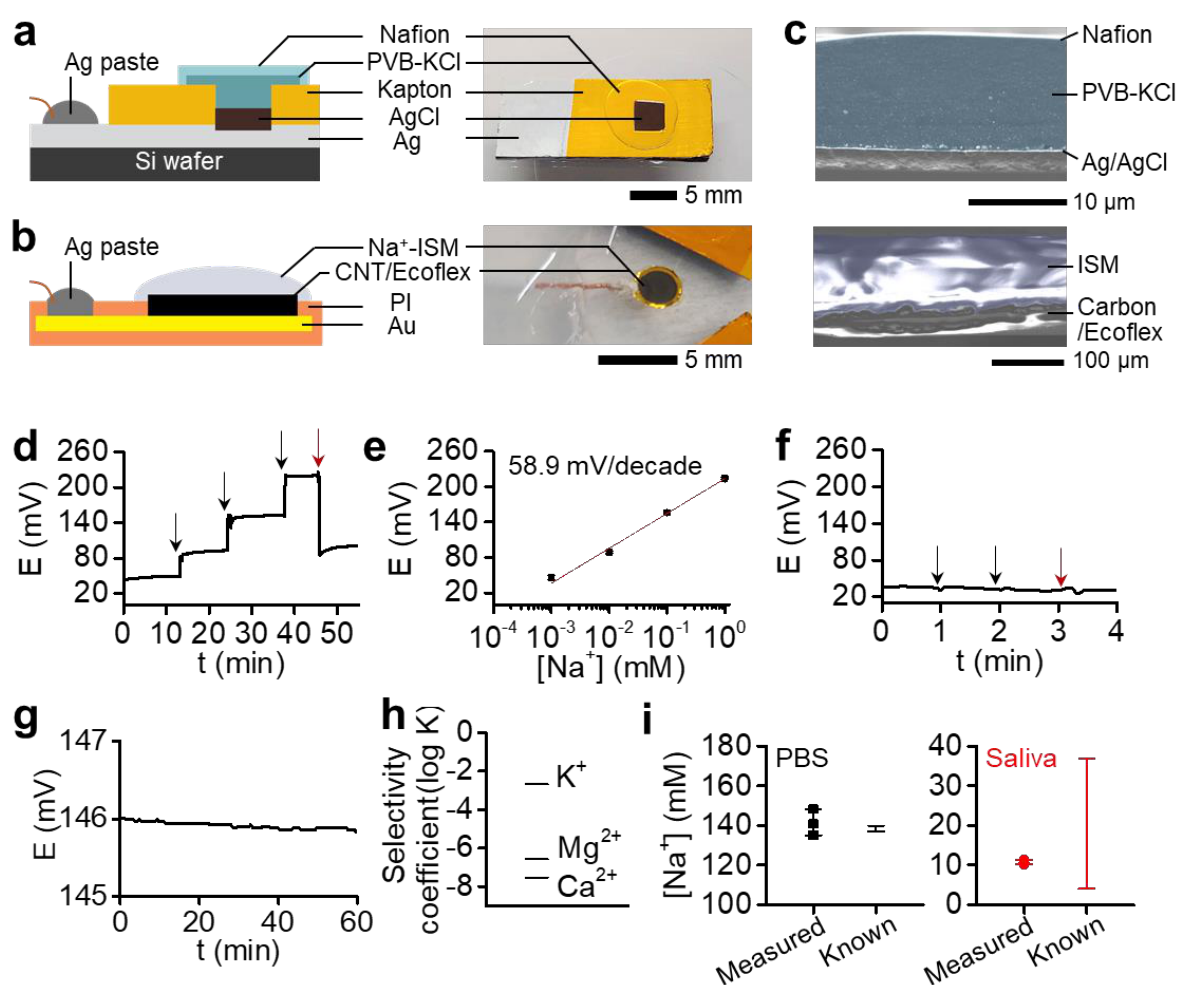
Figure 2. Characterization of a low-profile reference electrode (RE) and ion-selective electrode (ISE). ( a , b ) Schematic illustrations and photos of multilayered structures of ( a ) an Ag/AgCl/PVB-KCl/Nafion RE and ( b ) a carbon/Ecoflex-based ISE. ( c ) Cross-sectional SEM images of the RE (left) and ISE (right) in ( a , b ), respectively. ( d ) Voltage transient measured from an ISE in 10 − 3 –1 M sodium chloride solutions (black arrows) and saliva (red). ( e ) Linear correlation between measured voltages and sodium levels, showing a sensitivity of 58.9 mV/decade. ( f ) Voltage stability of a RE continuously measured with 10 − 3 and 10 − 2 sodium chloride solutions (black arrows) and saliva (red). The RE was used as a working electrode (WE) with a commercial RE as a RE/carbon counter electrode (CE) in a two-electrode system. ( g ) Voltage stability of a sensor composed of a pair of SS-ISE and RE in 0.1 M sodium chloride (0.2 mV/h). ( h ) Selectivity coefficient (log K) measured for three interference ions that are abundant in saliva. ( i ) Detection of sodium ion levels by using the flexible sensor system in phosphate-buffered saline (PBS) and saliva ( n = 3) and comparison of the measured data to known values.